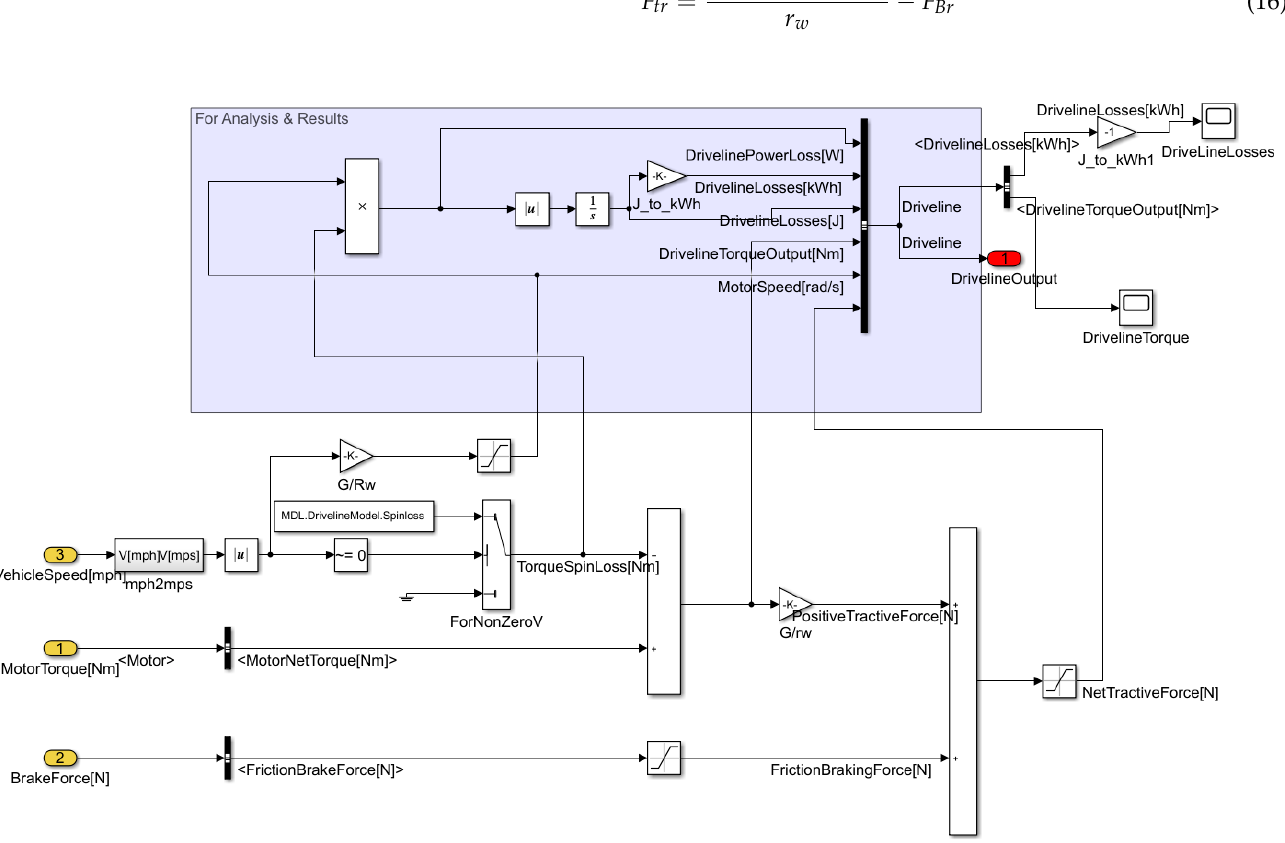
Figure 14. Driveline loss model and calculations Adapted from [16], MathWorks: 2020.